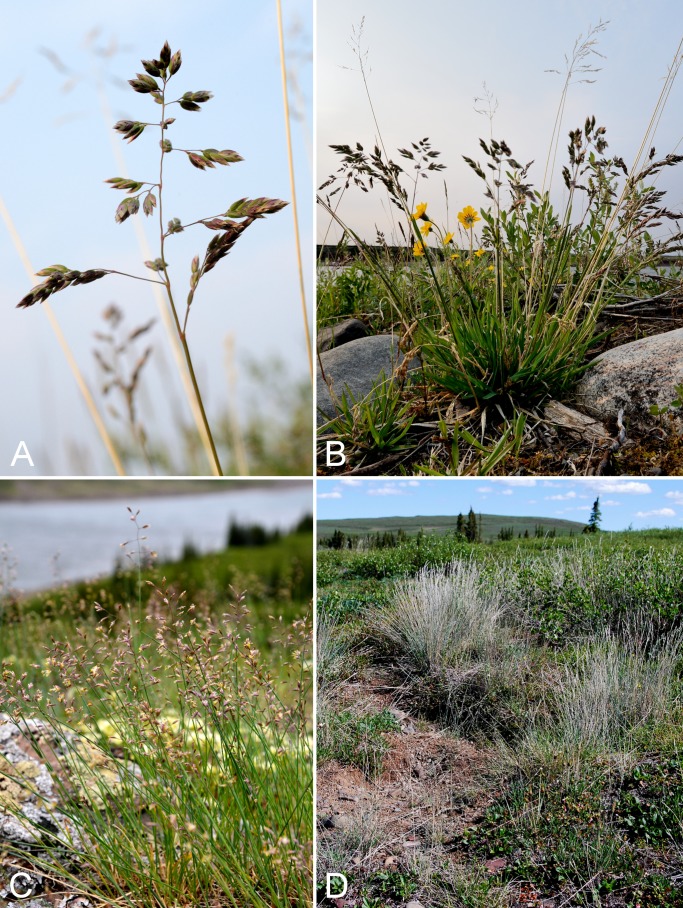
Poa alpina and Poa glauca subsp. glauca.Poa alpina: (A) inflorescence, Saarela et al. 3385. (B) Habit, Saarela et al. 3385. Poa glauca subsp. glauca: (C) habit, Saarela et al. 3631. (D) Habitat, Saarela et al. 3114. Photographs by R. D. Bull (A, B), P. C. Sokoloff (C), and J. M. Saarela (D).